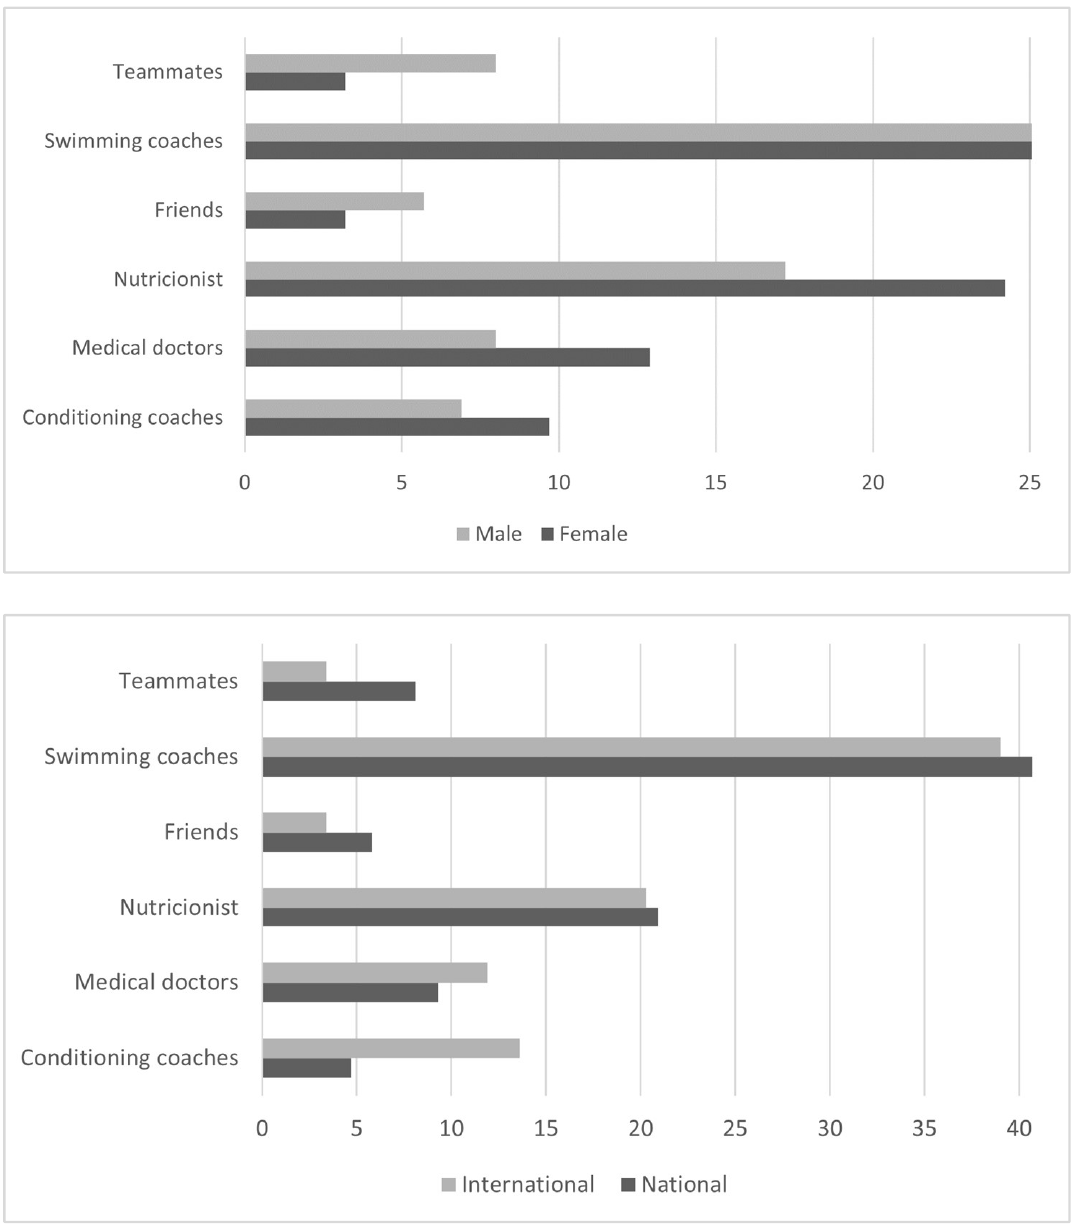
Figure 2. Sources of information or advice on the use of supplements by elite swimmers according to sex ( up ) and competitive level ( down ).